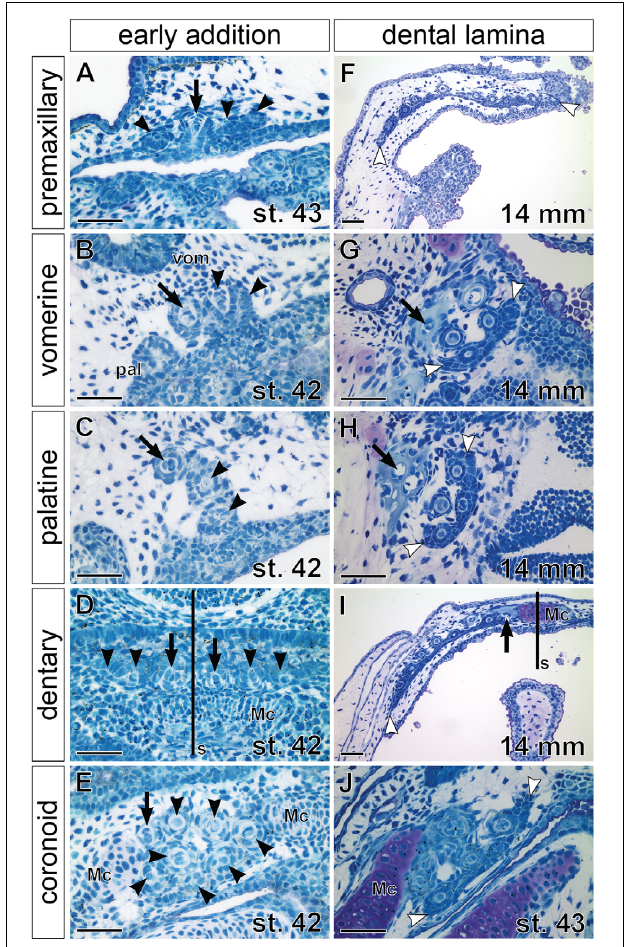
FIGURE 4 | Histological analysis of tooth addition within axolotl tooth fields. Horizontal sections (left sides shown, anterior to the top) through individual tooth fields show positions of the respective initiator-tooth (black arrows) and the newly added successive tooth germs (black arrowheads) at stages of early addition (A–E) and later morphogenesis (F–J) , when successional dental laminae are clearly discernible (demarcated by white arrowheads). (A) Premaxillary tooth field at stage of opened mouth (stage 43) contains three tooth germs (arrowheads) that are added laterally and medially to the initiator-tooth (arrow). (B,C) Vomerine (vom) and palatine (pal) tooth fields at stage 42 are composed of laterally positioned initiator-teeth (arrow) and two adjacent medially positioned tooth germs (arrowheads). (D) Dentary tooth fields are each initiated from the initiator-tooth (arrows) developing close to the mandibular symphysis (s) and new tooth germs (arrowheads) are added laterally along the Meckel’s cartilage (Mc). (E) Coronoid tooth field is composed of a patch of tooth germs (arrowheads) with the initiator-tooth present antero-laterally (arrow). (F) Premaxillary tooth field of a 14 mm TL larva shows arrangement into a tooth row. New tooth germs are added lingually from the successional dental lamina and, as the upper jaw grows, the premaxillary field expands by further addition of tooth germs at lateral and medial edges of the dental lamina (white arrowheads). (G,H) Vomerine and palatine tooth fields containing several teeth arranged into a tooth patch with new germs arising from the lingually positioned successional dental laminae (white arrowheads). Slight difference in composition exists between these tooth fields that can be ascribed due to the addition of first teeth antero-medially to the initiator-tooth (black arrow) in the vomerine field (B) and postero-medially in the palatine field (C) , and to the subsequent